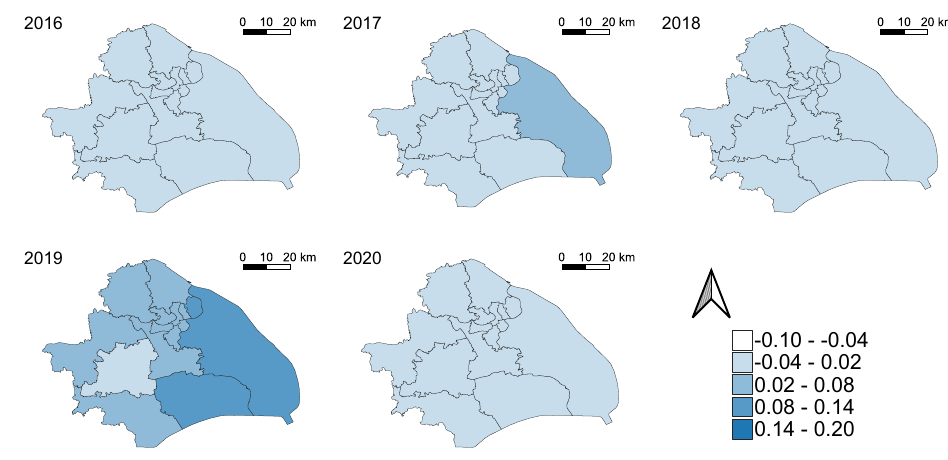
Figure 12. Average value of Wetness in each district.